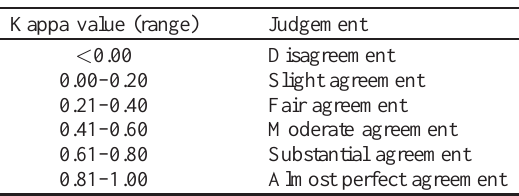
Table 1 Classification criterion of kappa statistic